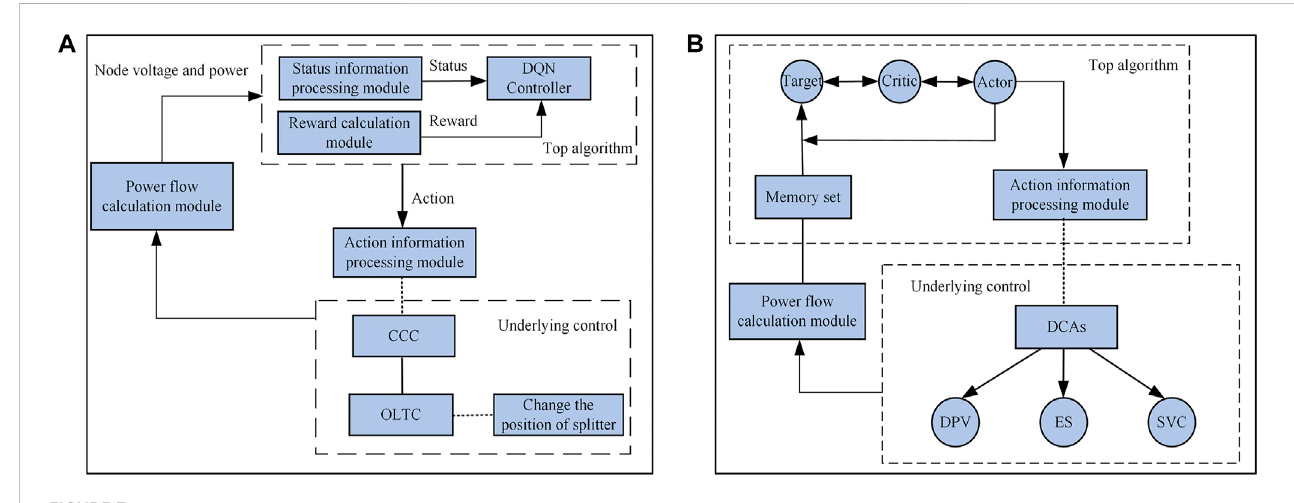
FIGURE 7 Voltage control architecture based on DQN-DDPG; (A) DQN algorithm; (B) DDPG